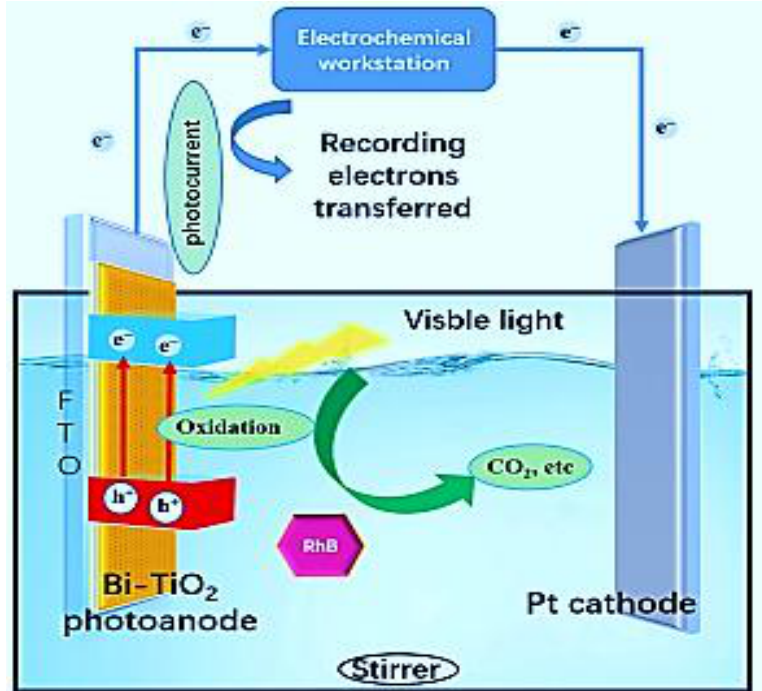
Figure 1. Schematic diagram showing the structure of PFC connecting with the electrochemical workstation [35]